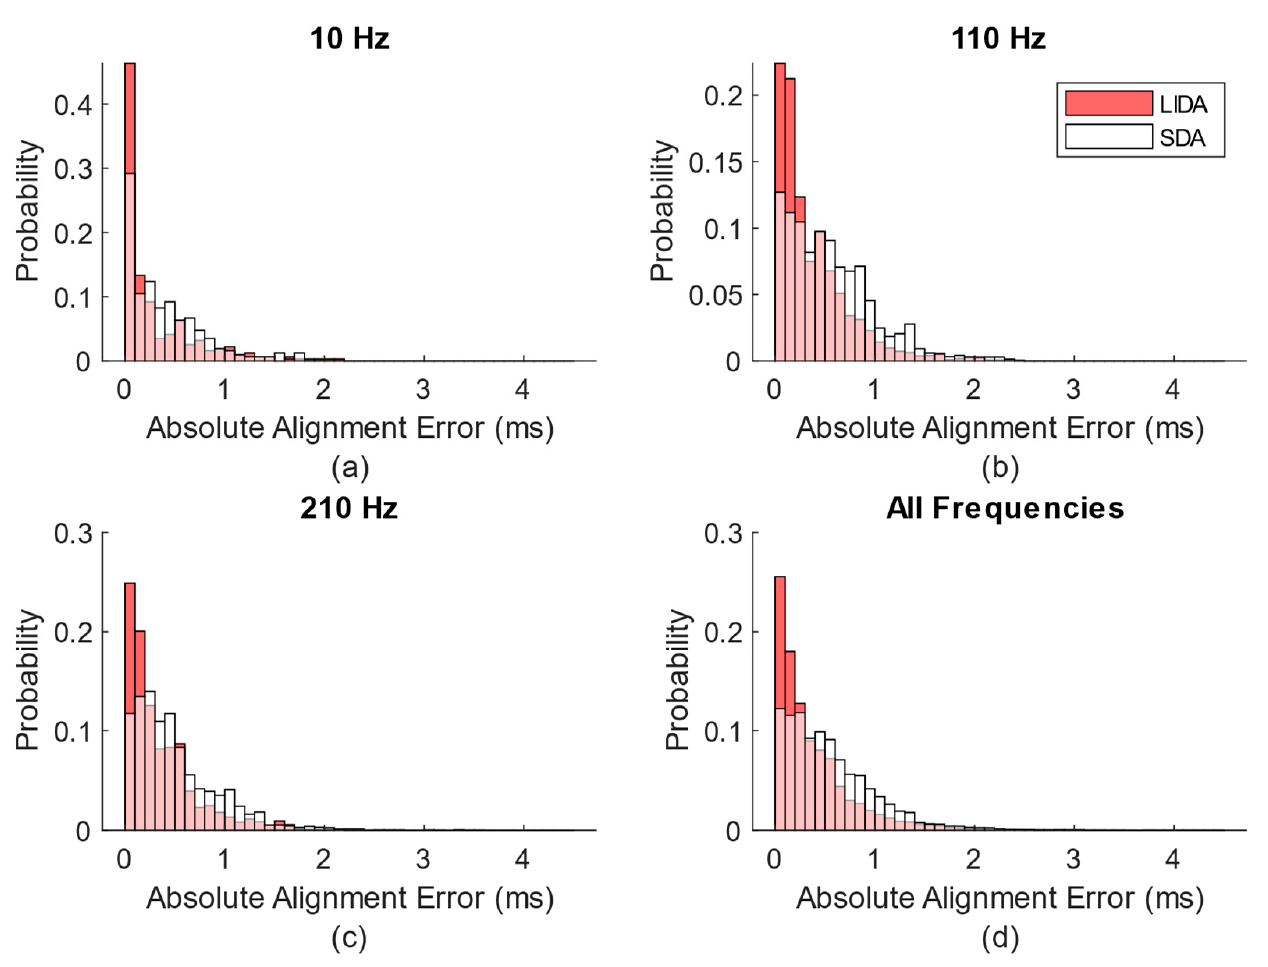
Figure 4. Histogram plot generated from absolute time alignment errors using input frequencies of 10 Hz, 110 Hz, and 210 Hz ( a – c ) and all input frequencies ( d ). The red bins were generated using LIDA and the white bins were generated using SDA, with the overlapped parts colored pink.